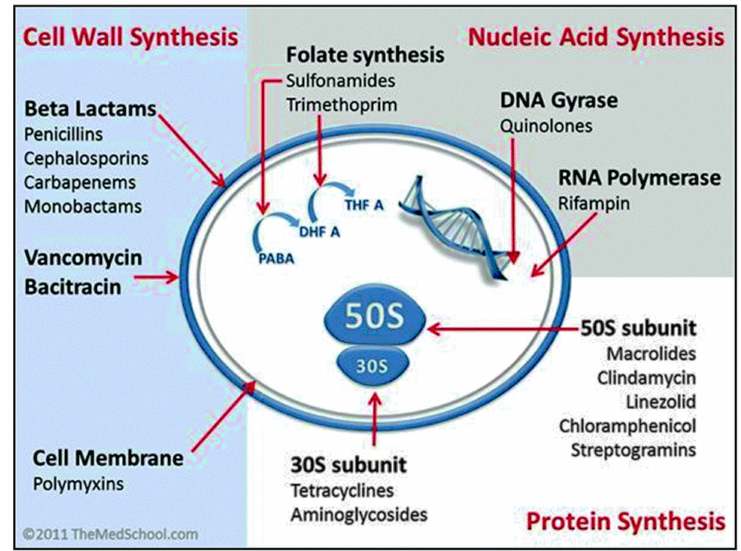
Figure 2. Mechanisms of action of currently used antibiotics (Image by Kendrick Johnson, licensed under the Creative Commons Attribution-Share Alike 3.0 Unported